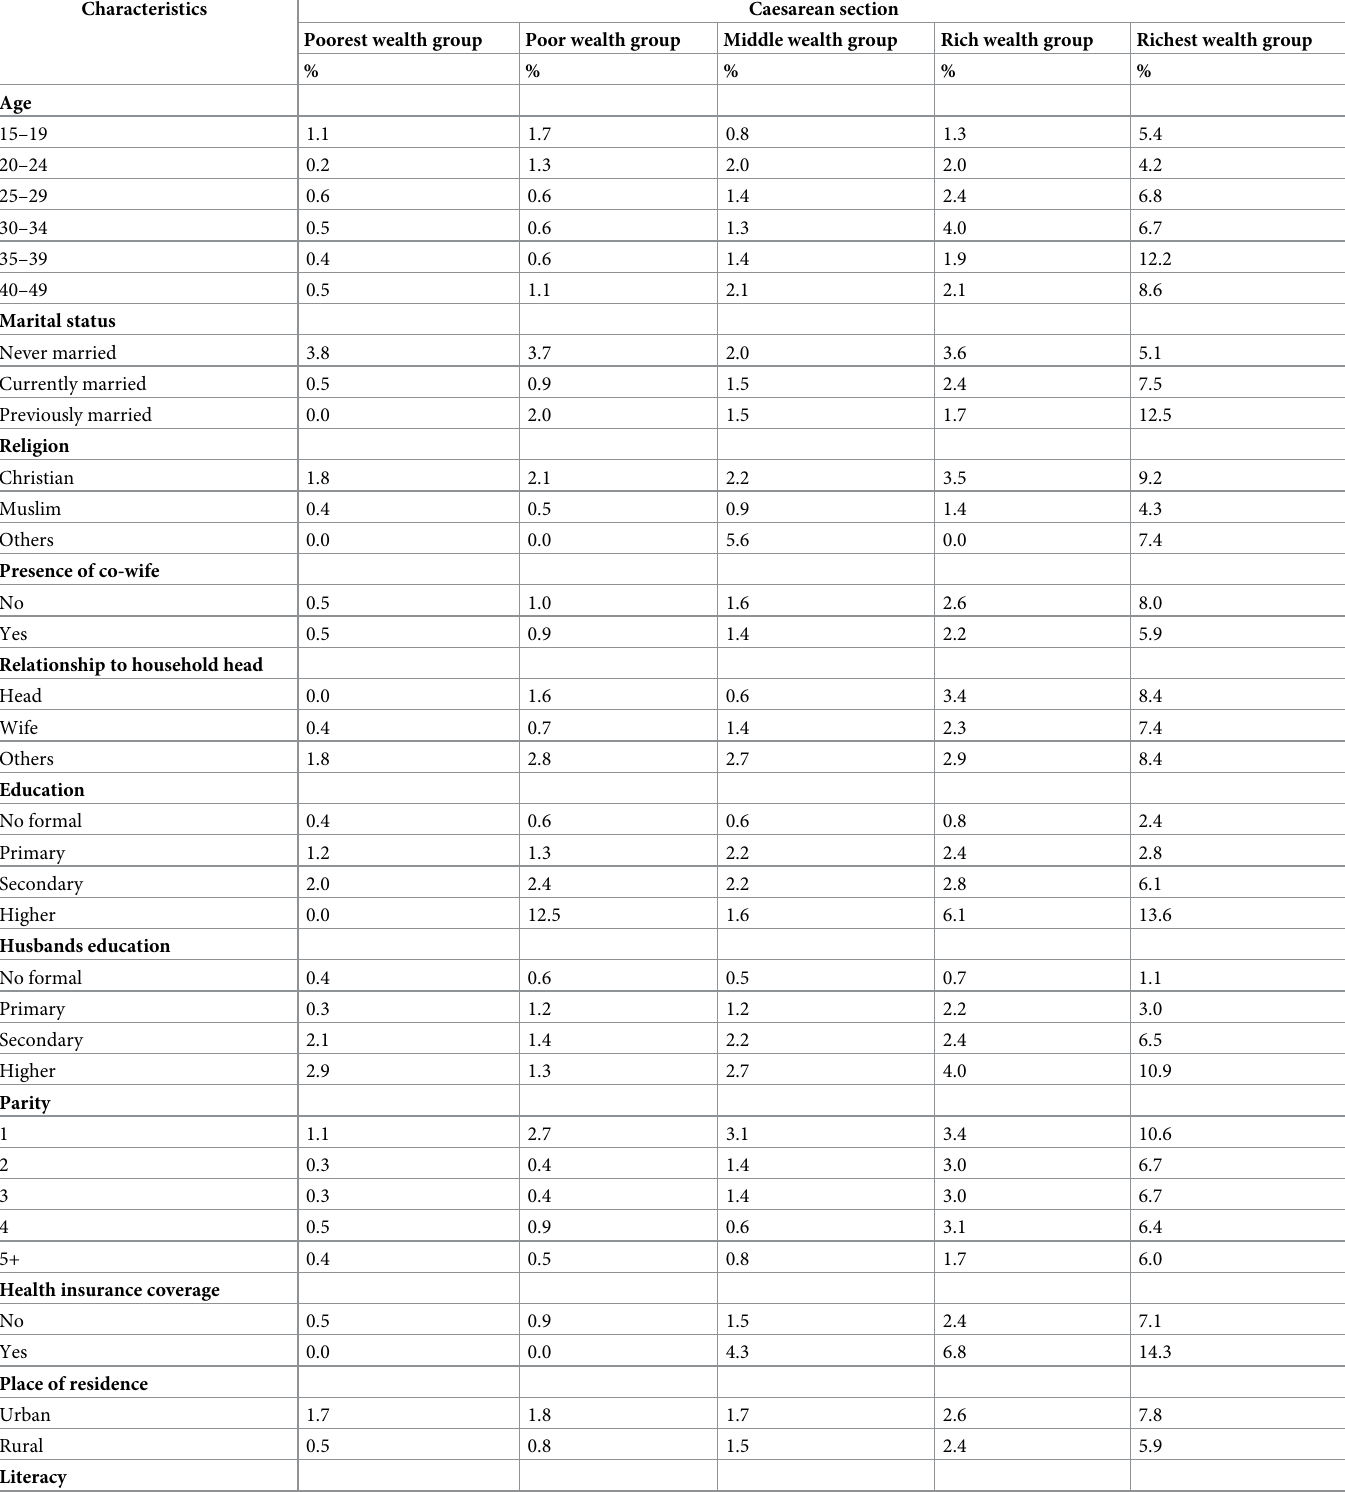
Table 3. Distribution of Caesarean section by wealth status and selected characteristics.